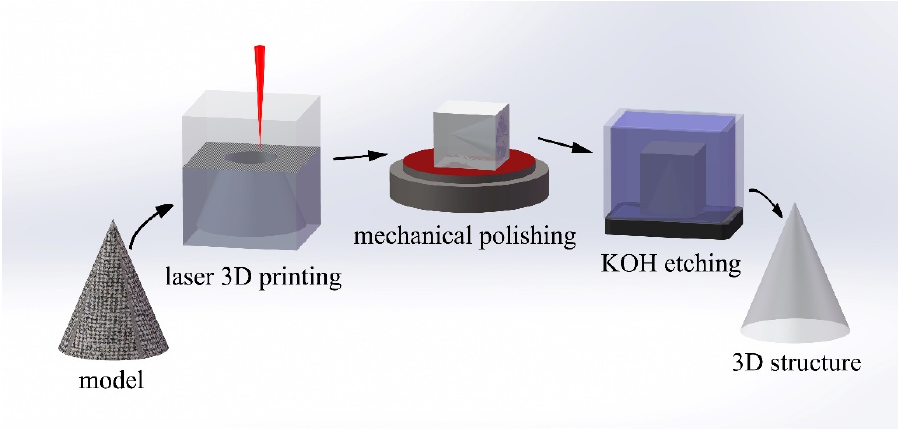
Figure 1. ( a ) Schematic of the experimental setup. ND, variable neutral density filter; L1 and L4, convex lens; L2 and L3, concave lens; AOM, acousto-optical modulators; CCD, charge-coupled device; OB, objective lens. Cross-sectional view of optical micrographs of lines inscribed in fused silica with ( b ) positively chirped 10 ps laser pulses, ( c ) transform-limited 190 fs laser pulses, and ( d ) negatively chirped 10 ps laser pulses. Scale bar: 25 μ m.